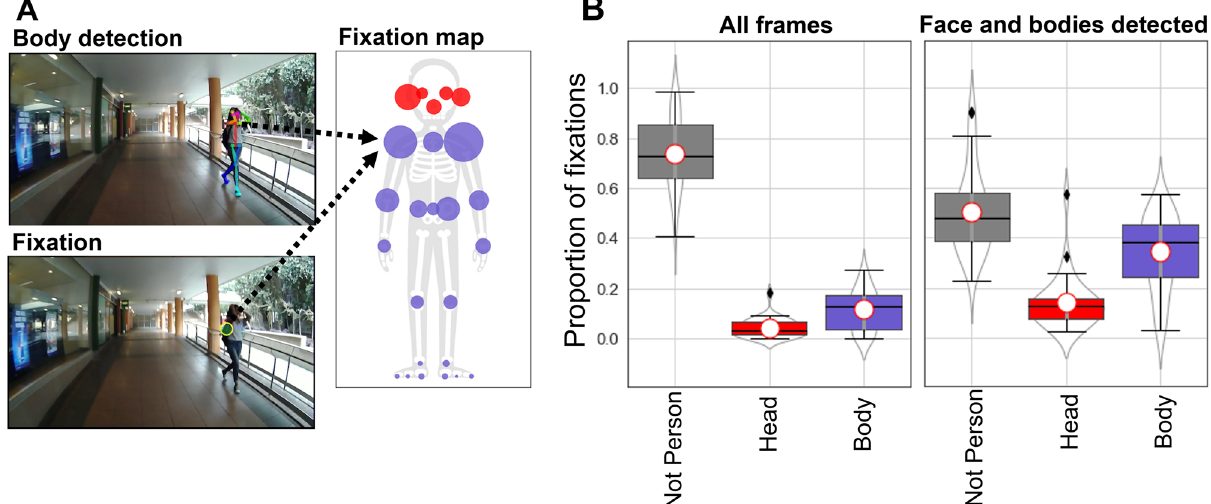
Figure 1. Dynamic region of interest (dROI) analysis of social attention while navigating a university campus. ( A ) Using data from a wearable eye-tracker, we extracted body landmarks from videos using OpenPose (top left) and co-registered viewers’ fixations towards these landmarks (bottom left). The skeleton figure shows a participant’s relative proportion of fixations to each body landmark, indicated by the size of the marker (all individual participant maps are available in Supplementary Materials, Sect. 1.4 and a video demonstration of the dROI method is shown in the Supplementary Video). ( B ) The left data panel shows boxplots of the proportions of non-person, head and body fixations as a proportion of all fixations in the recordings. The right data panel shows the proportions of non-person, head and body fixations only as a proportion of frames where the algorithm detected heads and bodies. See main text for